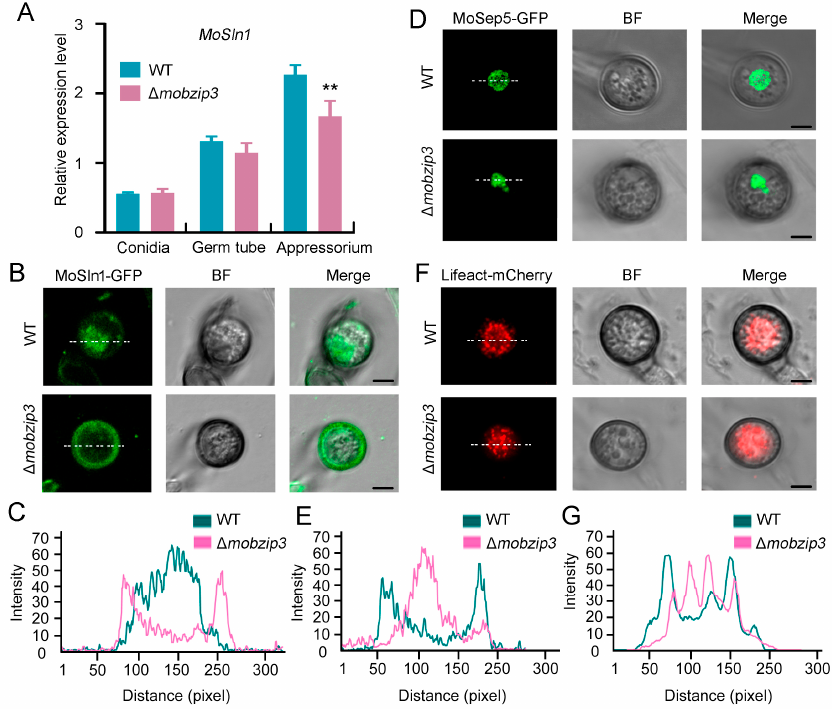
Figure 7. MoBZIP3 may function in MoSln1 mediated turgor recognition. ( A ), Quantitative real-time PCR analysis expression of MoSln1 in WT and ∆ mobzip3 . The experiments were repeated three times with similar results. Error bars represent ±SE of three biological replicates. Asterisks represent sig- nificant differences (** p < 0.01).Primers used in this experiment were listed in Supplemental Table S1. ( B , C ), Distribution analysis of MoSln1 in M. oryzae appressorium. Fluorescence observation of MoSln1 -GFP ( B ). Line scan analysis of MoSln1 -GFP ( C ) in ( B ); ( D , E ), Distribution analysis of MoSep5 in M. oryzae appressorium. Fluorescence observation of MoSep5-GFP ( D ), Line scan analysis of MoSep5-GFP ( E ) in ( D ); ( F , G ), Distribution analysis of Lifeact-mCherry labeled actin cytoskeleton in M. oryzae appressorium. Fluorescence observation of Lifeact-mCherry ( F ), Line scan analysis of Lifeact-mCherry ( G ) in ( F ). MoSln1 -GFP and MoSep5-GFP driven by their native promoters were expressed in WT and Δ mobzip3 . Fluorescence signals were observed at 24 h after conidia germed on glass coverslips under fluorescence microscopy in the WT and Δ mobzip3 appressorium. At least 50 cells were observed for each fluorescence analysis in this experiment. Bars = 5 μ m.